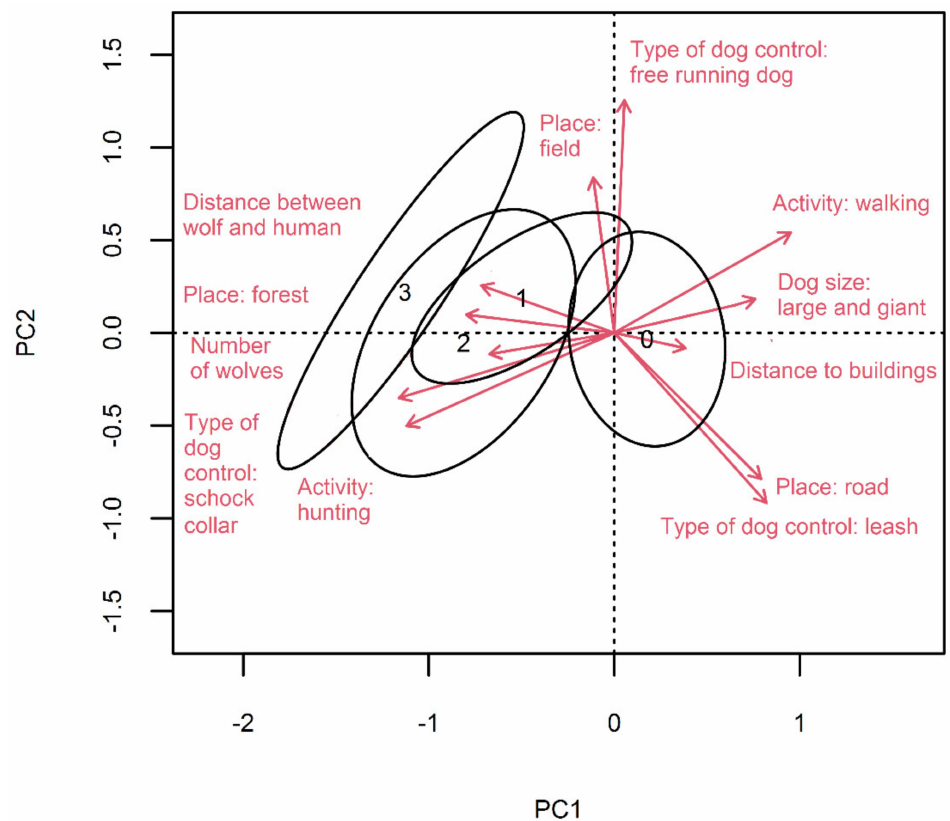
Figure 2. Biplot of principal component analysis based on the variables (arrows) that significantly influence dog–wolf interactions according to GLM analysis. Observations were grouped according to the degree of interaction (0 – no interaction, 1 –interaction without injuries, 2 – interaction with non-fatal injuries, 3 – interaction with fatal injuries) and presented as an ellipse (1SD from the centroid of the observation cloud). For categorical variables, each category is presented as a separate vector. The PCA1 axis accounted for 27.9% of the variance, PCA2 for